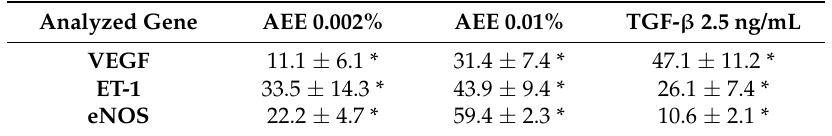
Table 2. Effects of AEE on microcirculation and vasodilation in endothelial cells. The gene expression level of VEGF, ET-1 and eNOS was measured in HUVEC incubated with two different concentrations of AEE (% of extract powder used in the assay, weight/volume) or TGF- β (2.5 ng/mL), used as positive control. The measures reported indicate the increases of gene expression level (expressed as %) of the treated samples compared to the untreated controls.